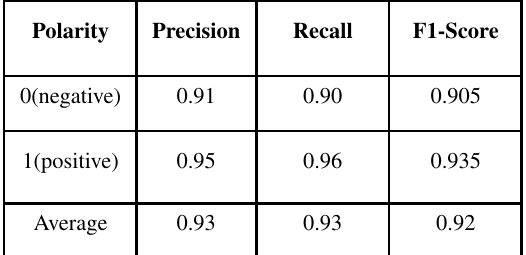
Fig. 7. Product Aspect Analysis